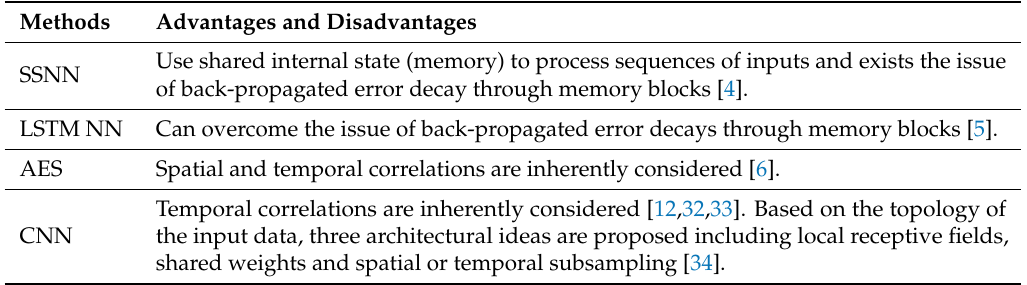
Table 1. Advantages and disadvantages of individual deep learning